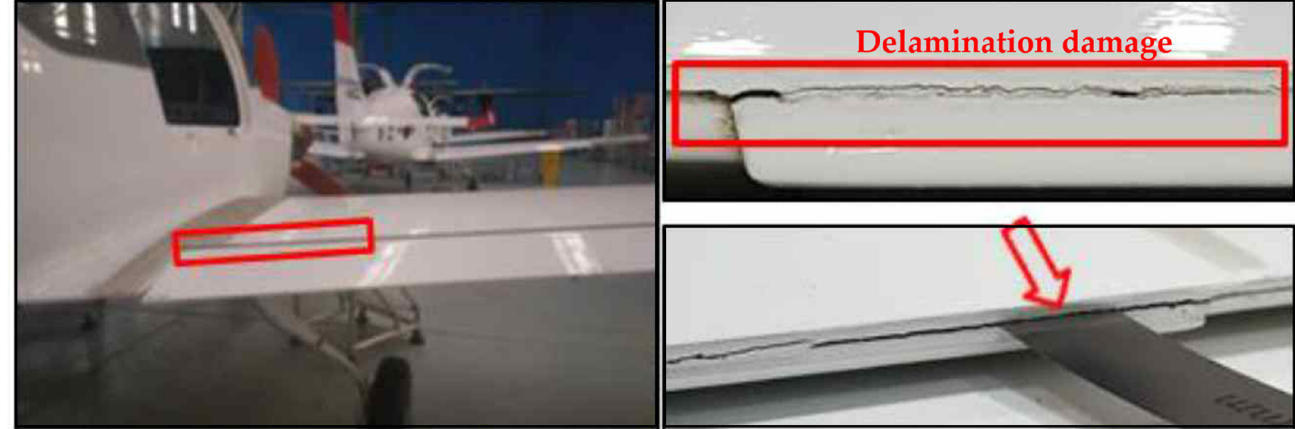
Figure 4. Comparison of the numerical and experimental fatigue delamination propagation curve [23,26].